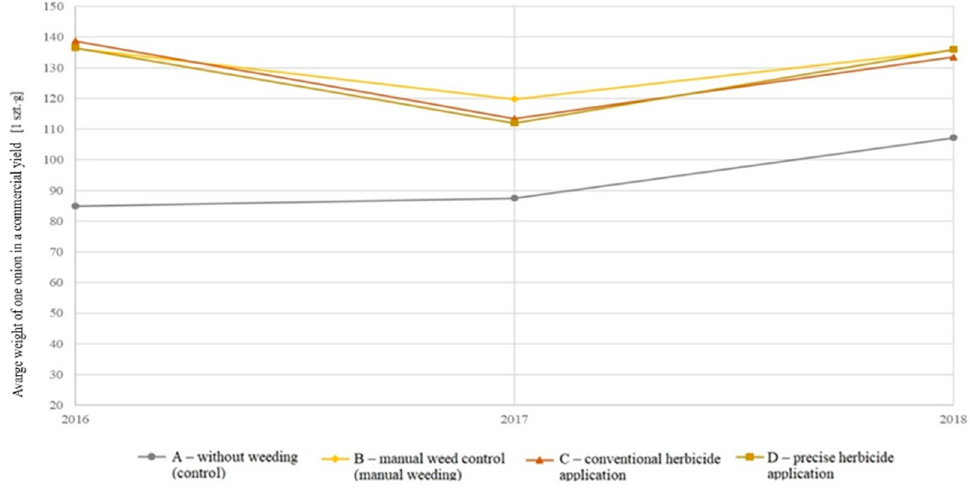
Figure 21. Reaction of the average weight of one onion in the commercial yield to changes in weather conditions depending on the weeding method (source: own work).